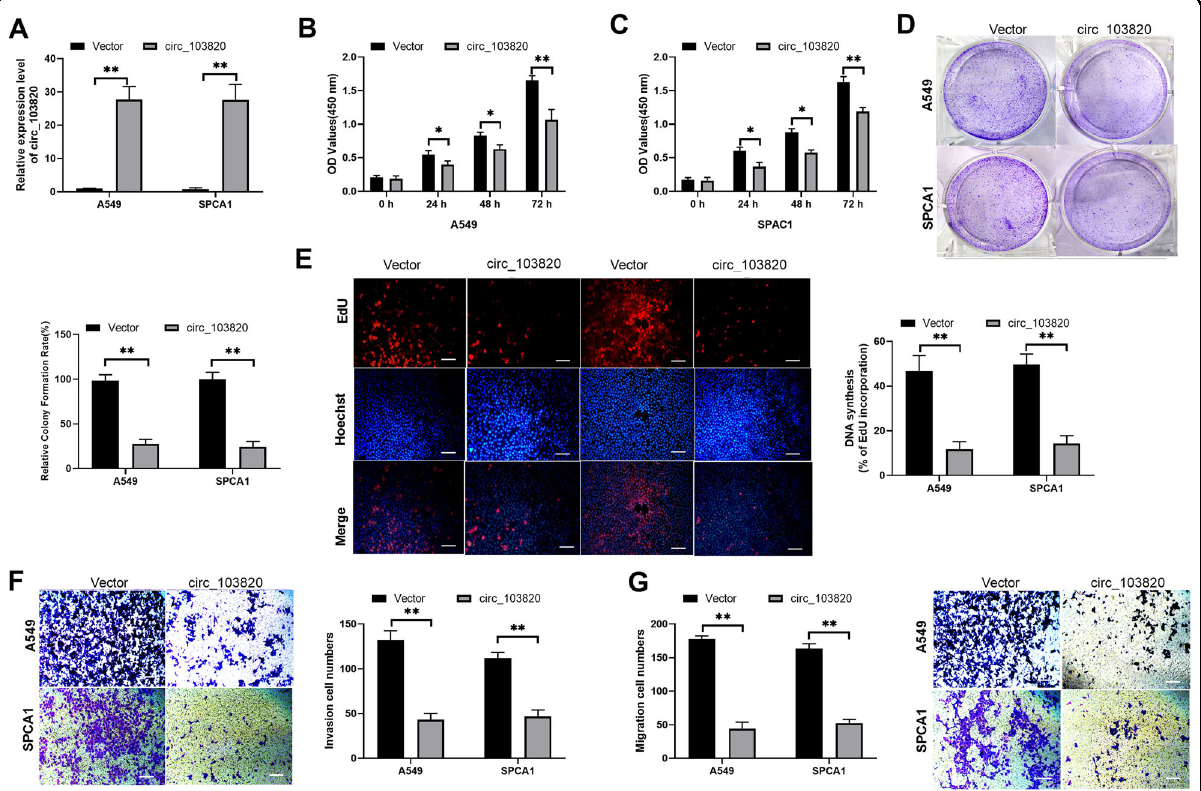
Fig. 3 Overexpression of hsa_circ_103820 suppressed the proliferation, migration, and invasion of lung cancer cells. A The effects of transfection with hsa_circ_103820-overexpressing plasmids were determined in A549 and SPCA1 cells. After transfection with hsa_circ_103820, the proliferation of A549 and SPCA1 cells was examined by applying CCK-8 ( B, C ), colony formation ( D ) and EdU staining assays ( E ). F Cell invasion was con fi rmed by Transwell assays in hsa_circ_103820-overexpressing A549 and SPCA1 cells. G The impacts of hsa_circ_103820 overexpression on cell migration were determined by Transwell assays. Scale bars, 100 μ m. Data are mean ± SD, n = 3. * P < 0.05, ** P < 0.01 (Student ’ s t